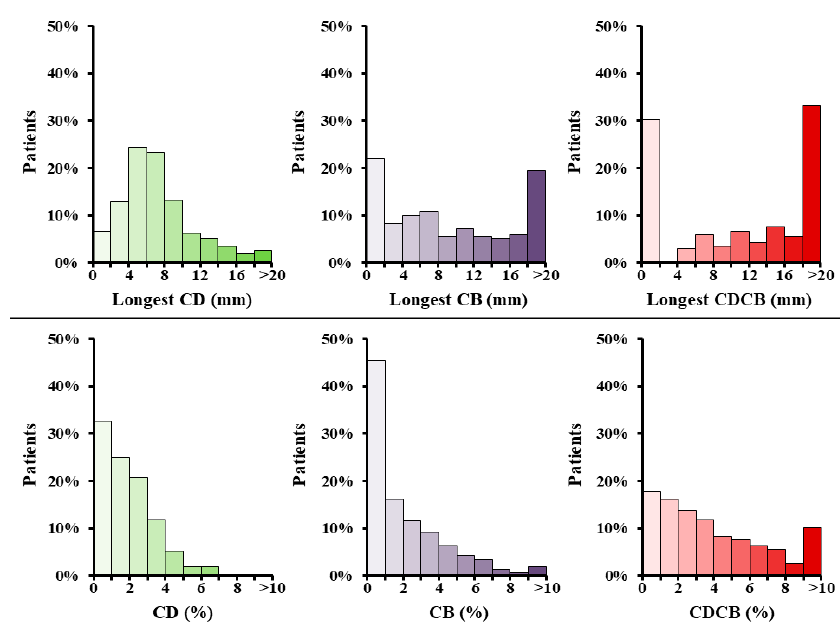
Figure 3. Incidence and extensiveness of conduction disorders. ( Upper panels ) Frequency histograms depicting the longest measured line of conduction delay (green), block (purple) and connected conduction delay and block (red) per patient. ( Lower panels ) Frequency histogram illustrating the percentage of conduction delay (green), block (purple) and combined (red) per patient. CB = conduction block; CD = conduction delay; CDCB (mm) = length of connected conduction delay and block; CDCB (%) = sum of conduction delay and block.